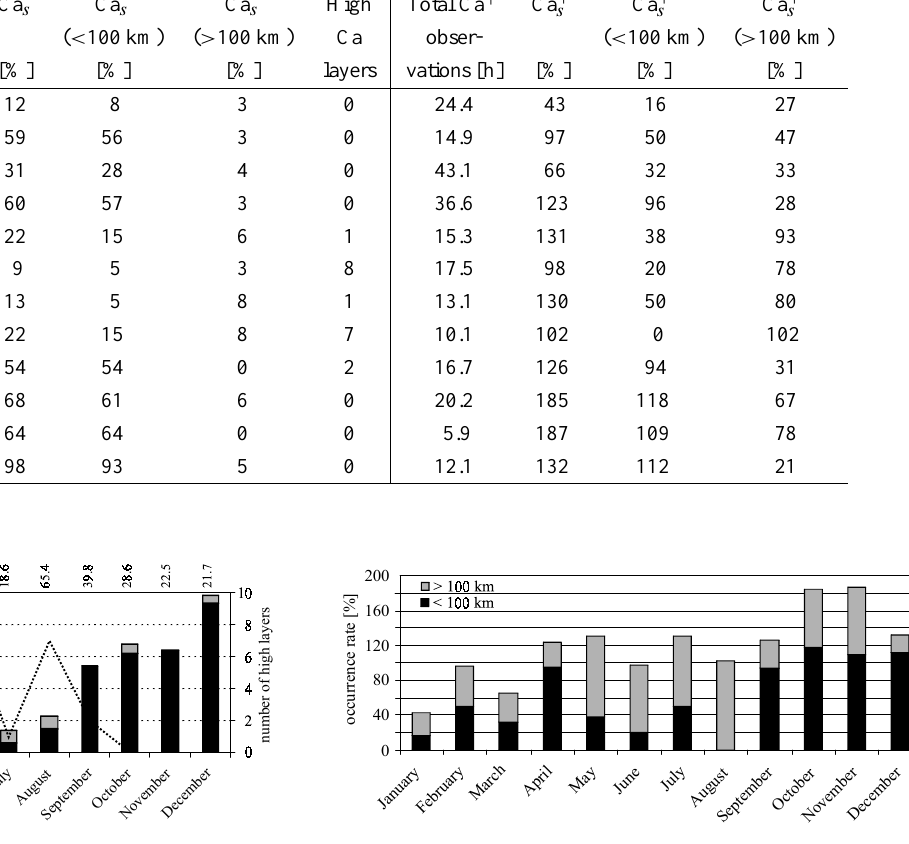
Fig. 9. Seasonal variation of the occurrence of sporadic neutral Ca layers (columns, based on exact observation time) and of so-called high Ca layers (dotted line, based on night mean profiles). The portions of Ca s above and below 100 km altitude are marked by different colors.